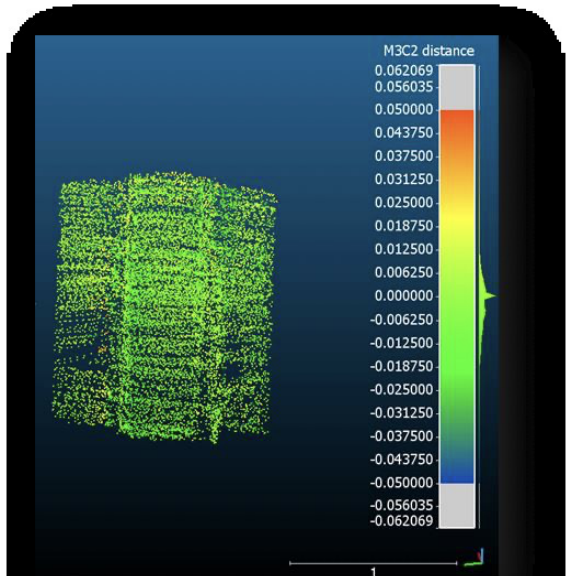
Figure 10: LiBackPack-GeoSLAM comparison result for a portion of a